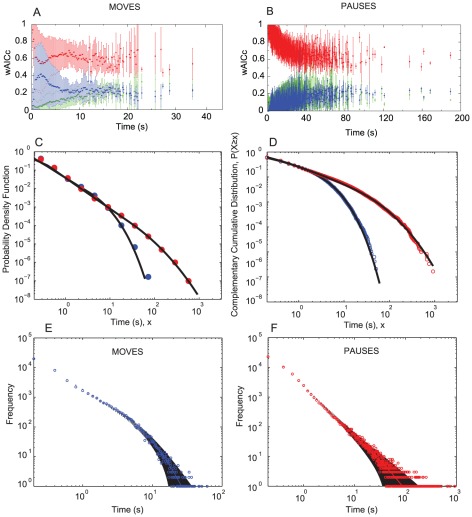
Detailed analyses of moves and pauses.The SPWMC analysis with bounded power-law, red, pure power-law, green, and bounded exponential, blue, for moves (A) and pauses (B). A value of weighted Akaike information criteria (wAIC) of one gives the maximum weight of evidence in favour of the models. The results here are means for all individuals. Error bars indicate +/− one SD. The probability density functions (C) and the complementary cumulative distribution plots (D) and for moves, blue, and pauses, red, showing the empirical data and the model fits for the power law with a stretched exponential tail model (black line). μ is the scaling parameter of the power-law, β is a parameter that tells us the deviation of the tail from an exponential. For moves: μ = 1.49, β = 0.55; for pauses: μ = 1.67, β = 0.23. (E–F) shows the observed and expected distributions for moves and pauses. Log-log plot of the frequency distribution of different move (E) and pause lengths (F). Open circles show the observed distribution from our data and dots show the expected distribution from the model fit (a power-law with a stretched exponential tail model). We assume a Poisson distribution for the deviations from the expected values for each bin. The black error bars show +/−2 SD from our expected value.